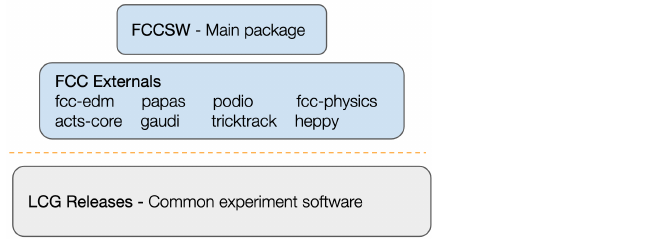
Figure 2. The FCC software stack, which is built with Spack (upper blue boxes), but bootstrapped from the CMake built LCG release (lower grey